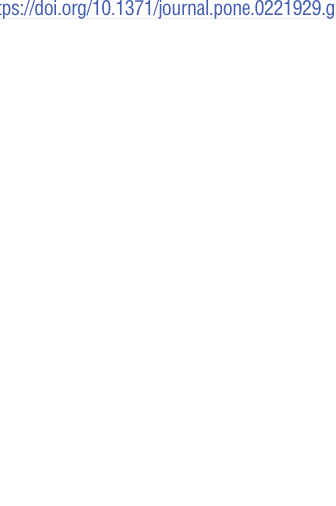
PLOS ONE | https://doi.org/10.1371/journal.pone.0221929 August 29,